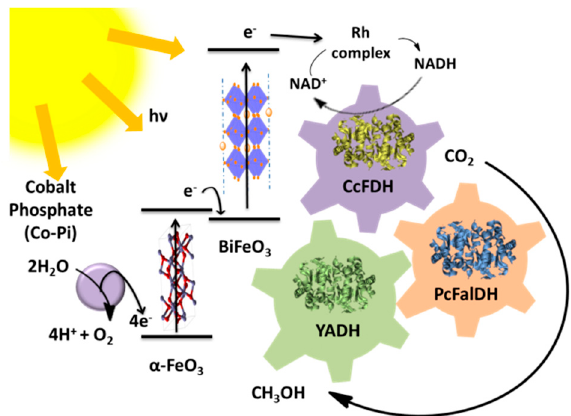
Figure 14. Schematic diagram of the light-assisted synthesis of methanol from CO 2 via an enzyme cascade (formaldehyde dehydrogenase, formate dehydrogenase, and alcohol dehydrogenase) [183].